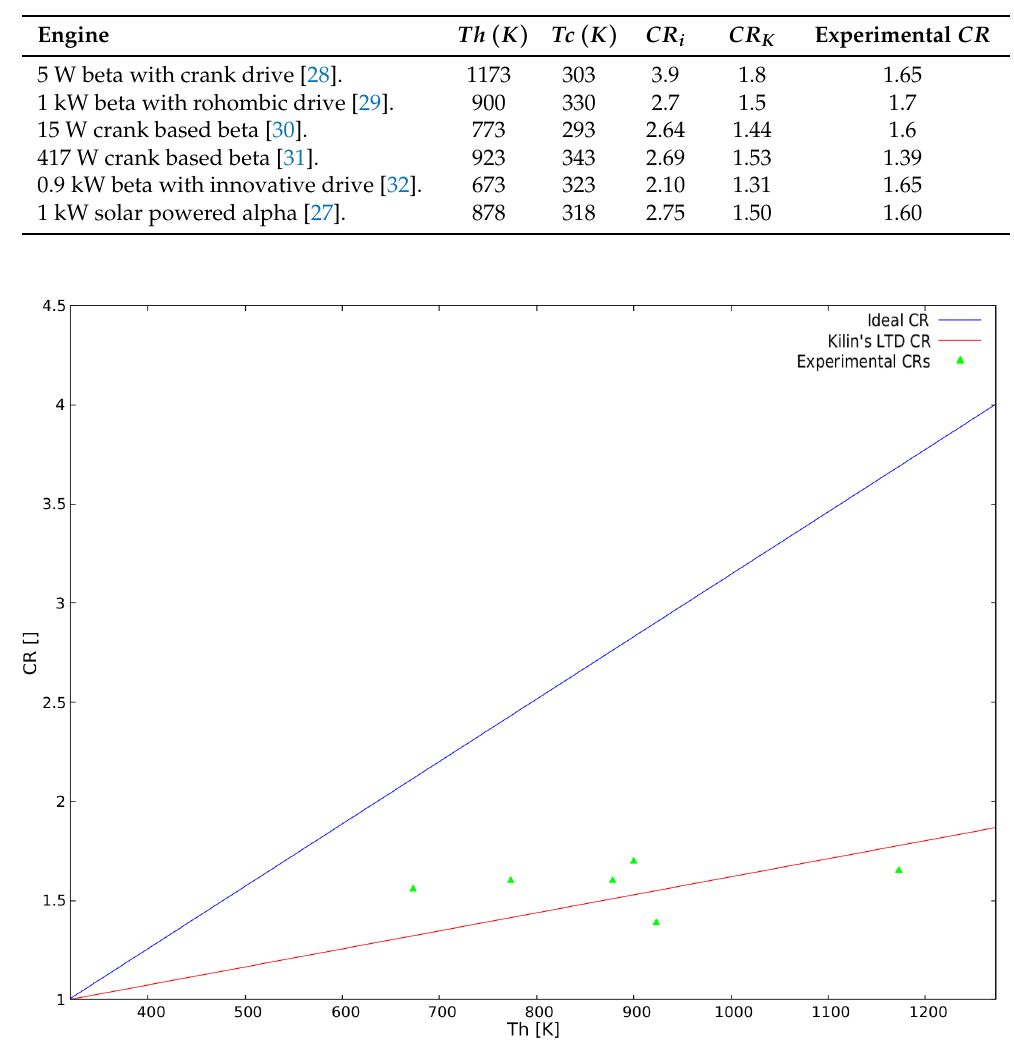
Figure 9. Ideal ( CR i ), Kolin’s experimental low temperature difference (LTD) ( CR K ) and experimental high temperature difference (HTD) engine’s CRs